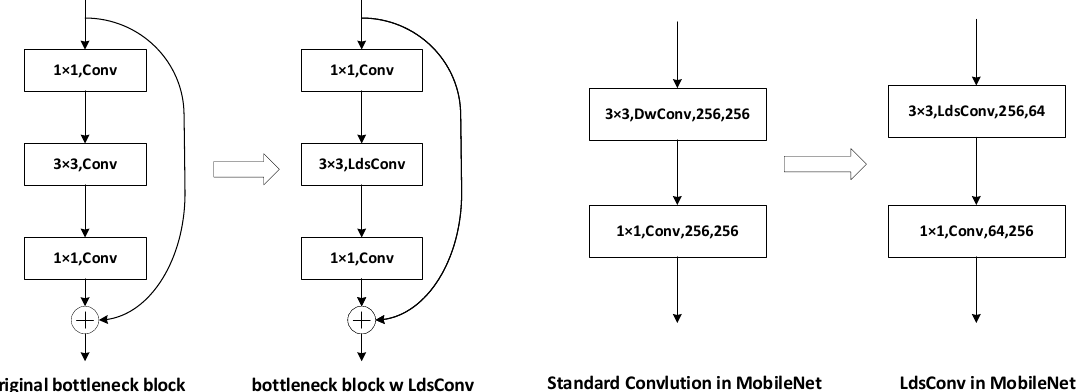
Figure 4. The replacement of original convolutional filters with LdsConv. Left: The replacement in ResNet. We directly replace the 3 × 3 convolution with our proposed LdsConv in the bottleneck block. Right: The replacement in MobileNet. We replace the original 3 × 3 convolution and reduce the number of output channel of the LdsConv and input channel of the sequent 1 × 1